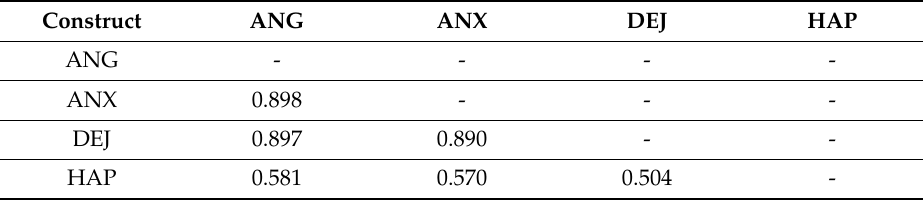
Table 6. Discriminant validity: heterotrait-monotrait (HTMT)